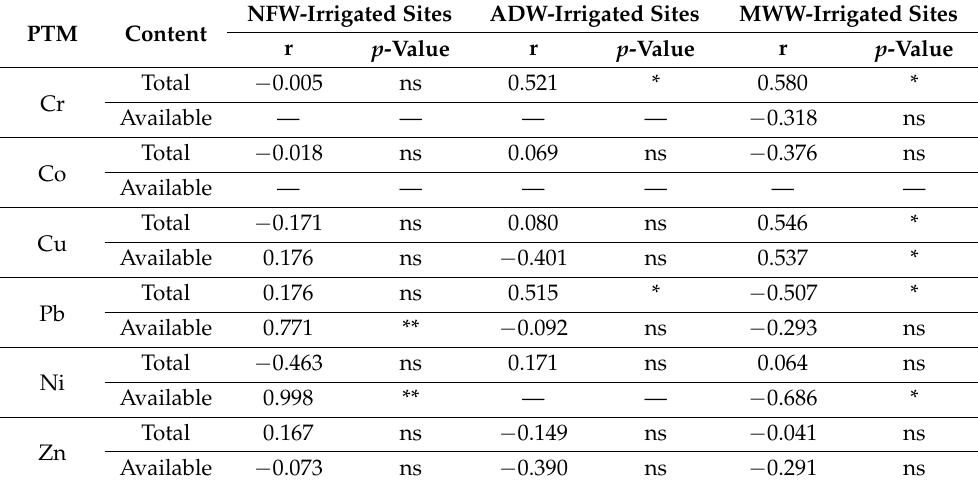
Table 4. Pearson’s correlation coefficient (r) and probability ( p ) value between metal concentrations in irrigation water and